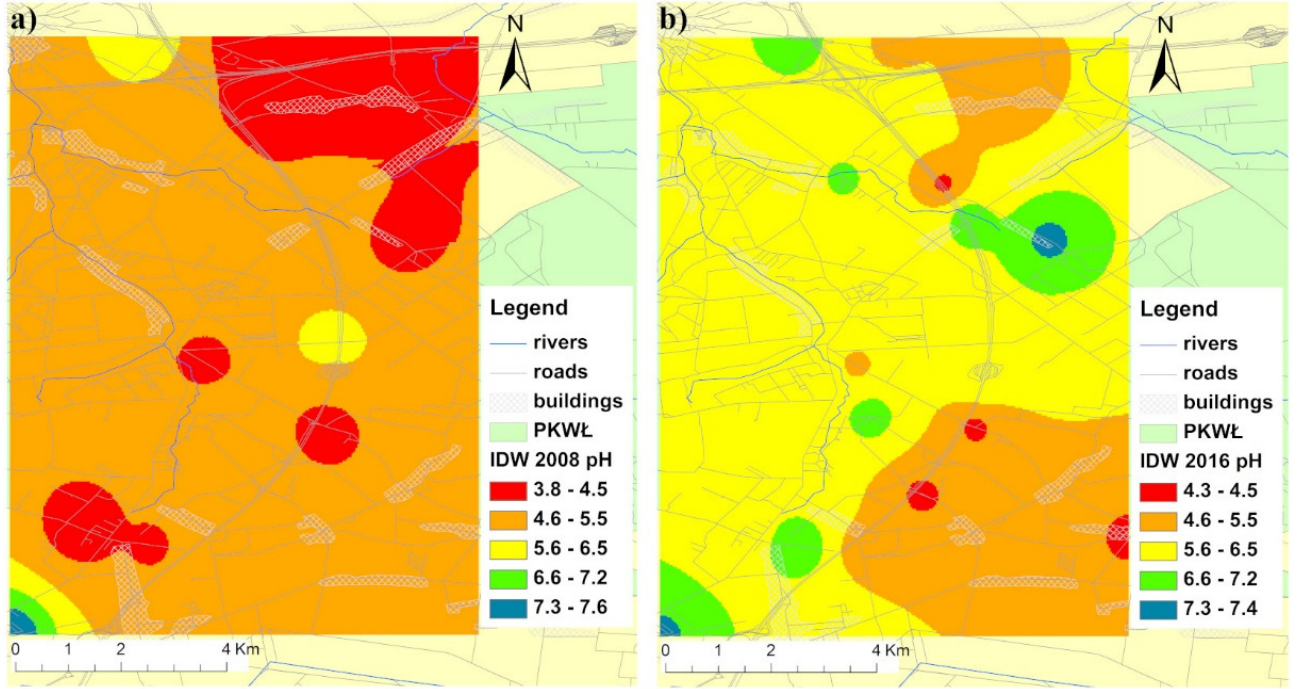
Figure 3. Spatial distribution of ( a ) pH (2008); ( b ) pH (2016).